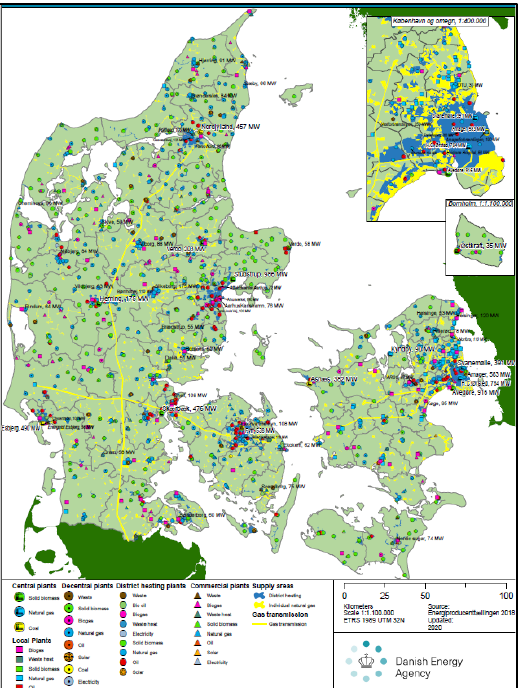
Figure 10. Danish heat supply infrastructures in 2020. Source: [86] .